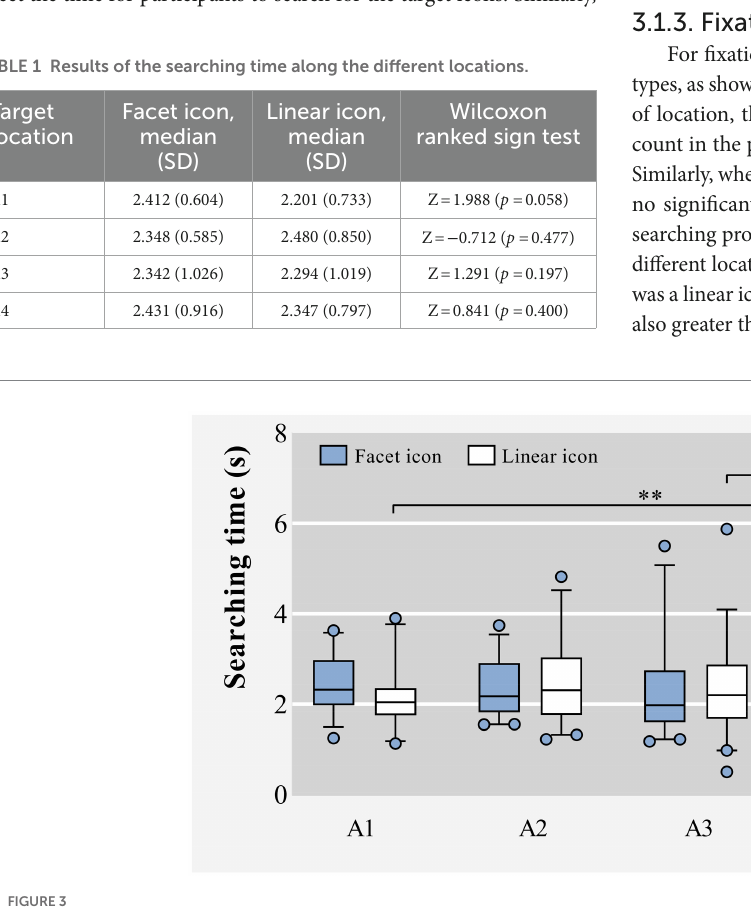
FIGURE 3 Box plots of raw data for the searching time in circular